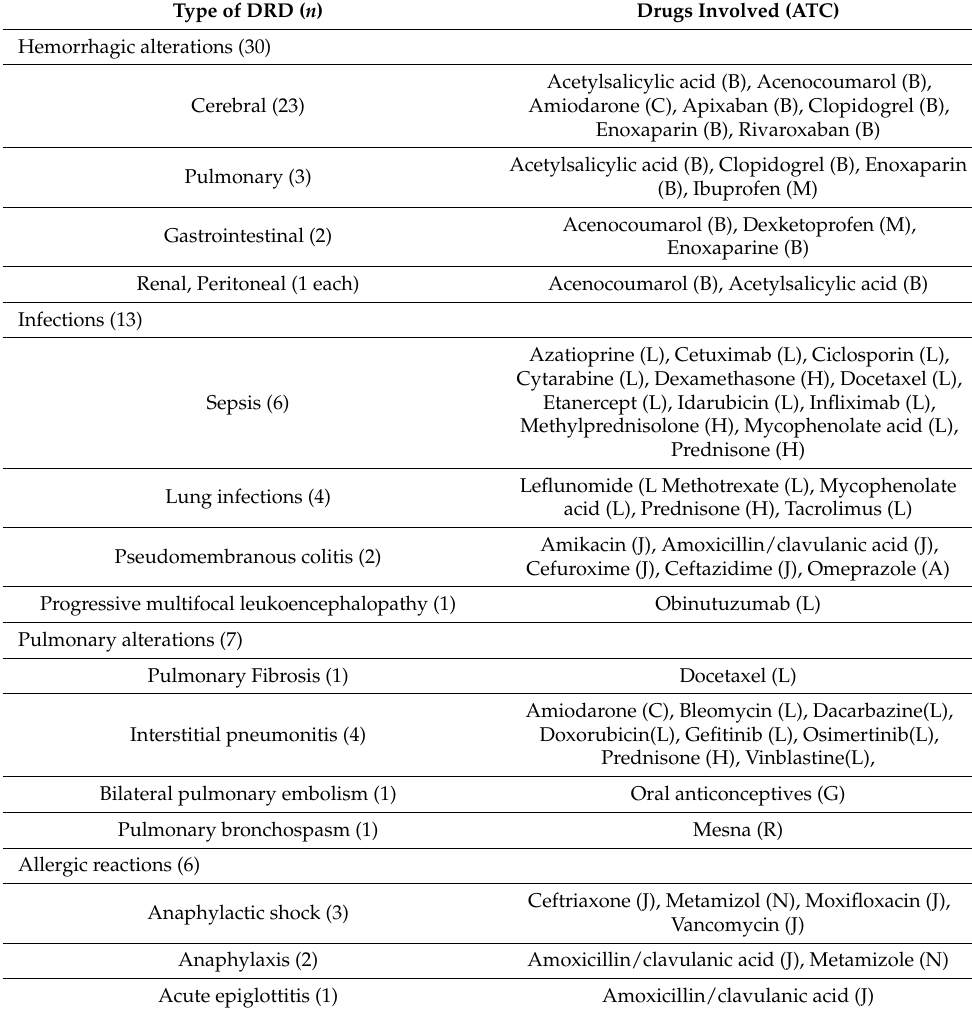
Table 6. Association between type of DRD and drug